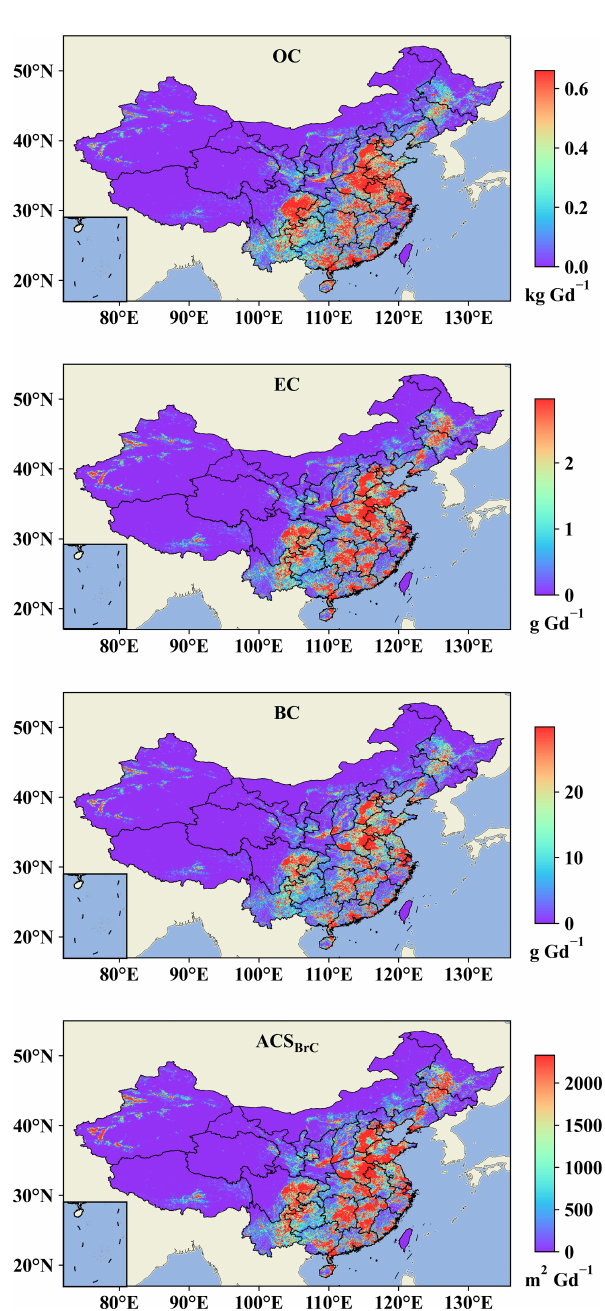
Figure 5. Spatial distribution of CA emissions from the FMSs in China in 2018. The color bar shows the emissions in each grid (where grid is denoted as